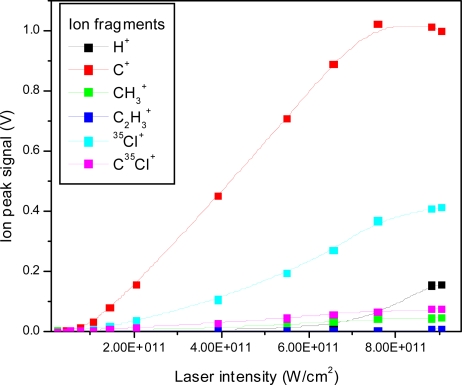
Ion peak signals as a function of laser intensity for H+, C+, CH3+, C2H3+, 35Cl+, C35Cl+ fragment ions using 266 nm laser radiation with 8 ns pulse duration.